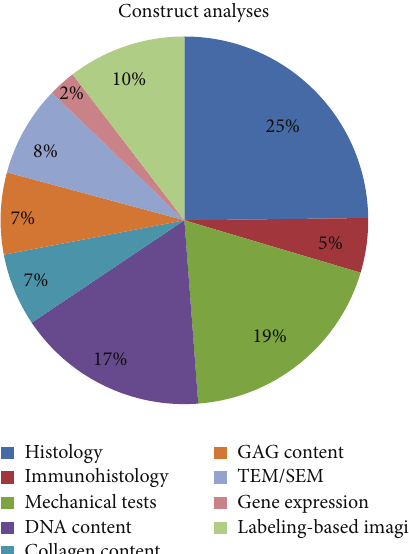
Figure 6: Construct analyses. The pie chart shows the relative distribution of analyses performed to assess the quality of the decellularization and reseeding of the tendon